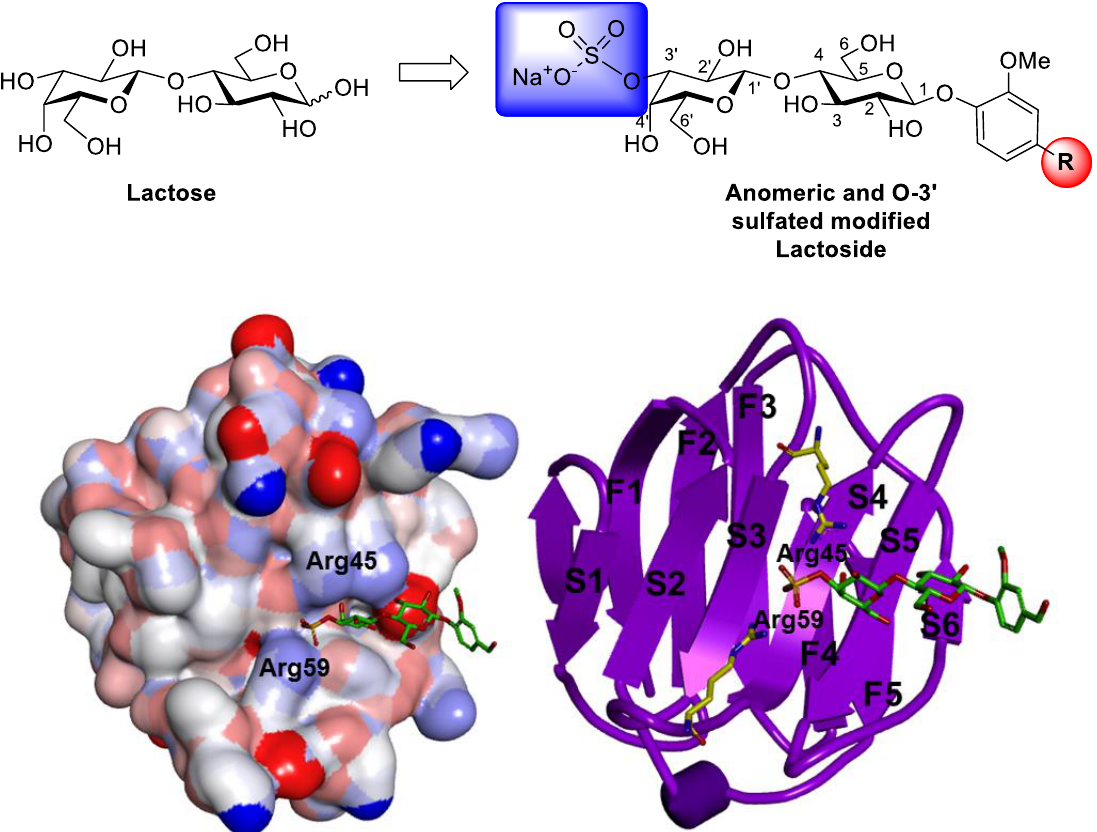
Figure 1. Top panel: Synthetic strategy for simultaneous modifications of lactose at the anomeric position with aromatic vanillin aglycon together with incorporating an anionic sulfate group at O-3’. Lower panel : Left panel: Predicted Connelly surface of the Gal-8 N-terminal (PDB 3AP6) with docked compound 12 that was superimposed to the original O-3’-sulfated lactose. Right panel : Schematic representation of Gal-8 N-terminal illustrating the beta strands and Arg45 and Arg59 (S4 section) are clearly in electrostatic contact with the sulfate group [4,27].